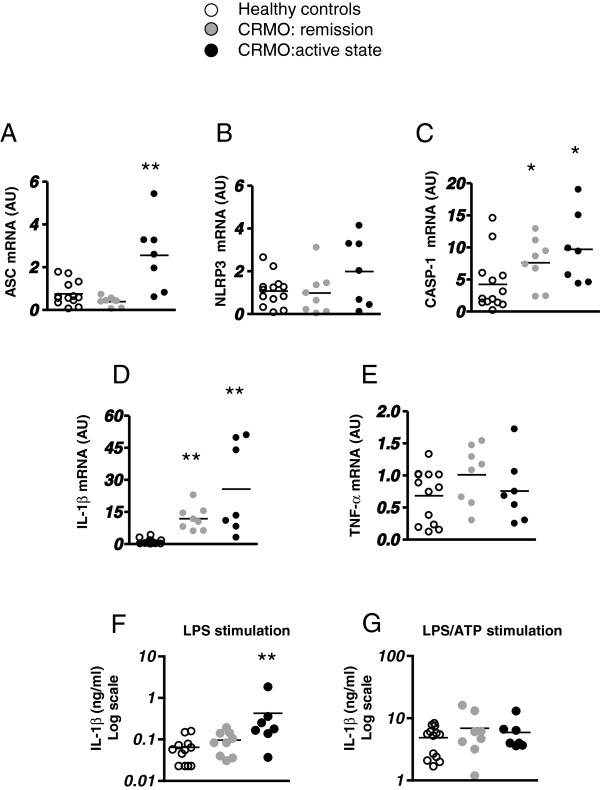
Characterization of PBMCs from CRMO patients. (A-E) Real Time-PCR analysis of gene products involved in the regulation of IL-1β, including ASC, NLRP3, CASP-1, IL-1β and of the pro-inflammatory cytokine TNF-α in freshly isolated PBMCs obtained from CRMO patients in remission (gray dots) or with active disease (black dots) and healthy controls (white dots). Values are presented as arbitrary unit (AU). (F-G) IL-1β released in supernatants by PBMCs isolated from CRMO patients in remission or in active disease and from healthy controls, after stimulation with 10 ng/ml LPS for 3 hours (F) or 10 ng/ml LPS for 2 hours followed by treatment with 2 mM ATP for 1 hour (G). IL-1β was measured by ELISA. Black lines represent the mean value. *p < 0.05, **p < 0.01 vs healthy controls.